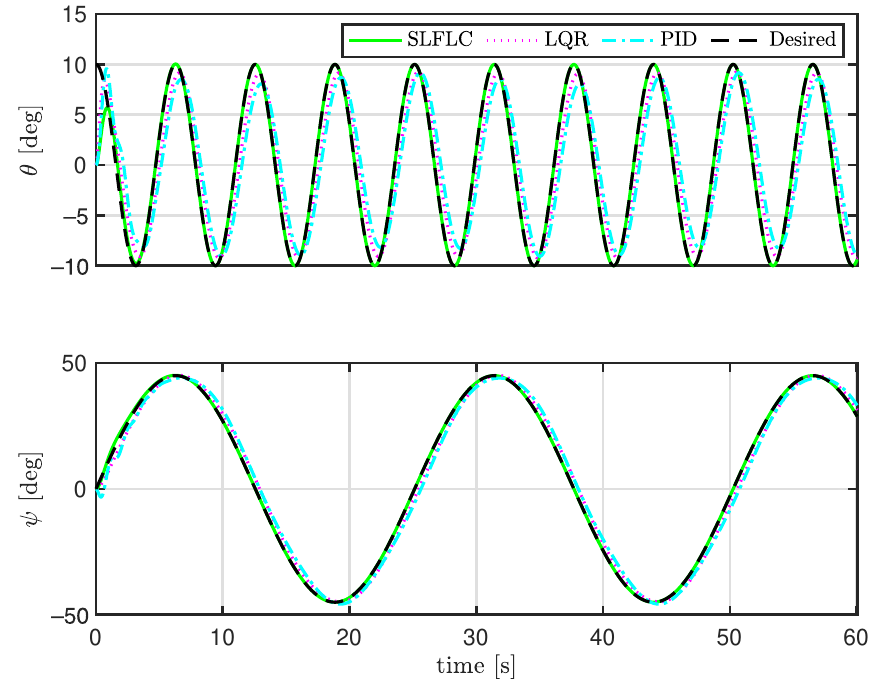
Figure 2. Trajectory tracking (Case